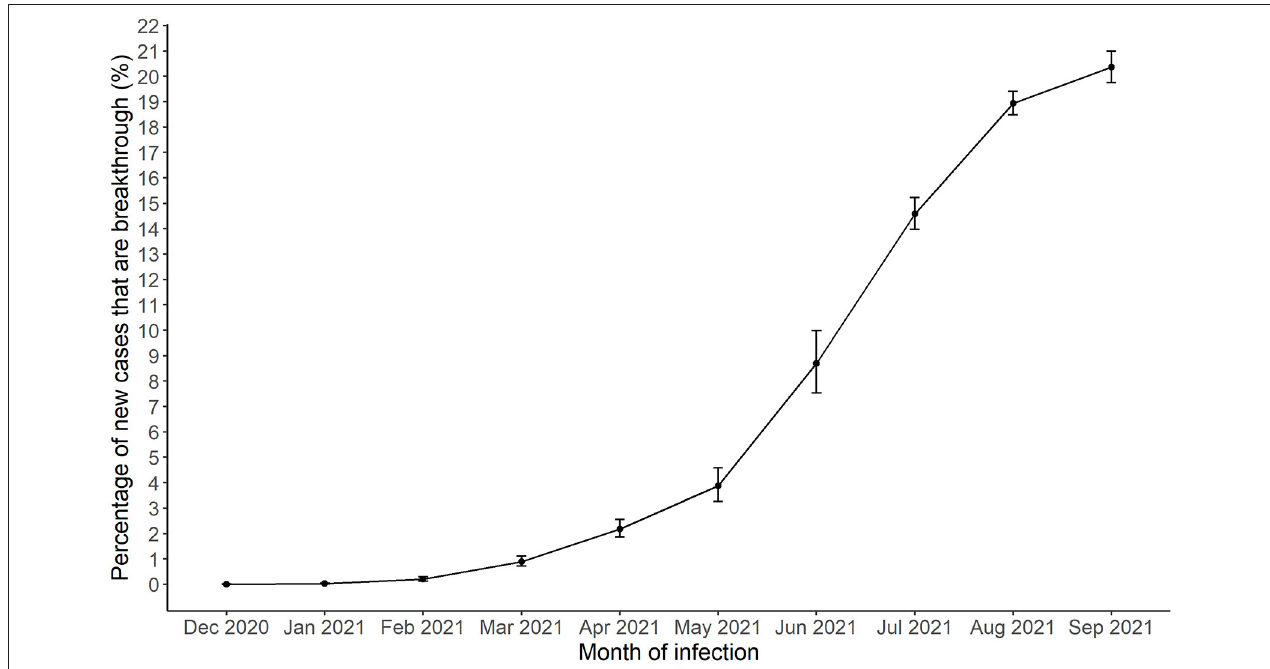
FIGURE 1 | Monthly breakthrough SARS-CoV-2 infections in Harris County Jurisdiction area from December, 2020 to September, 2021.